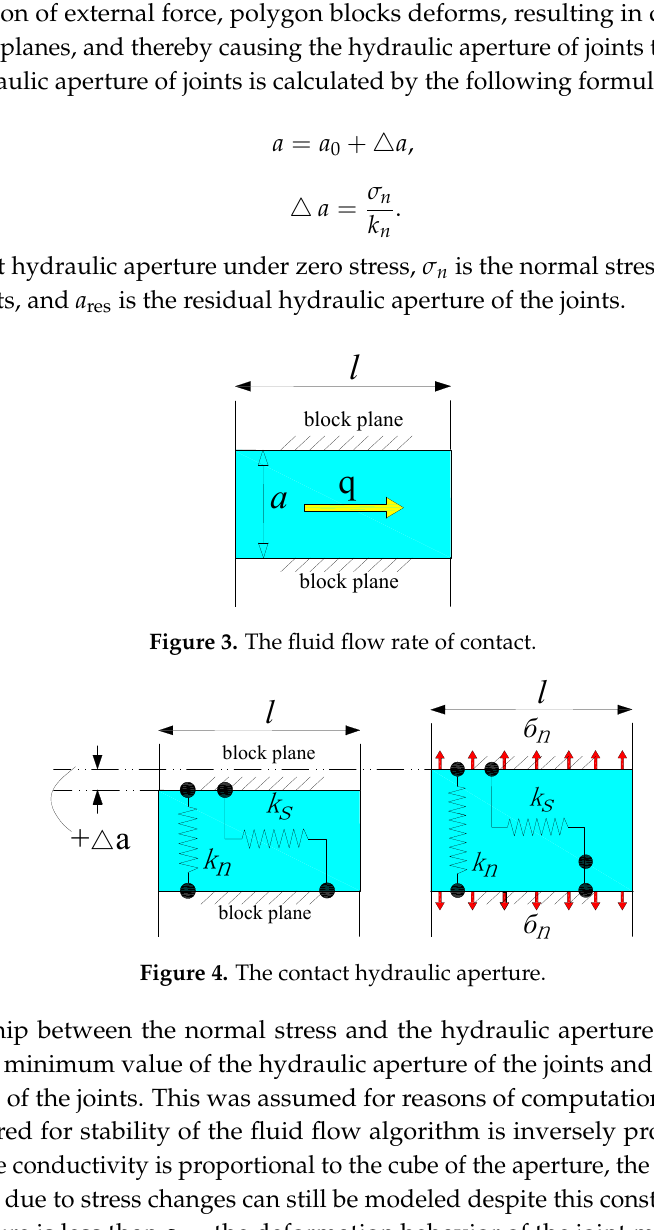
Figure 4. The contact hydraulic aperture. The relationship between the normal stress and the hydraulic aperture of joints is shown in Figure 5. a res is the minimum value of the hydraulic aperture of the joints and a max is the maximum hydraulic aperture of the joints. This was assumed for reasons of computational efficiency, because the timestep required for stability of the fluid flow algorithm is inversely proportional to the joint conductivity. As the conductivity is proportional to the cube of the aperture, the considerable variation in the permeability due to stress changes can still be modeled despite this constraint. When the value of the joint’s aperture is less than a res , the deformation behavior of the joint mechanics has no effect on the joint aperture. The hydraulic aperture value of the joints is a res . When the value of the